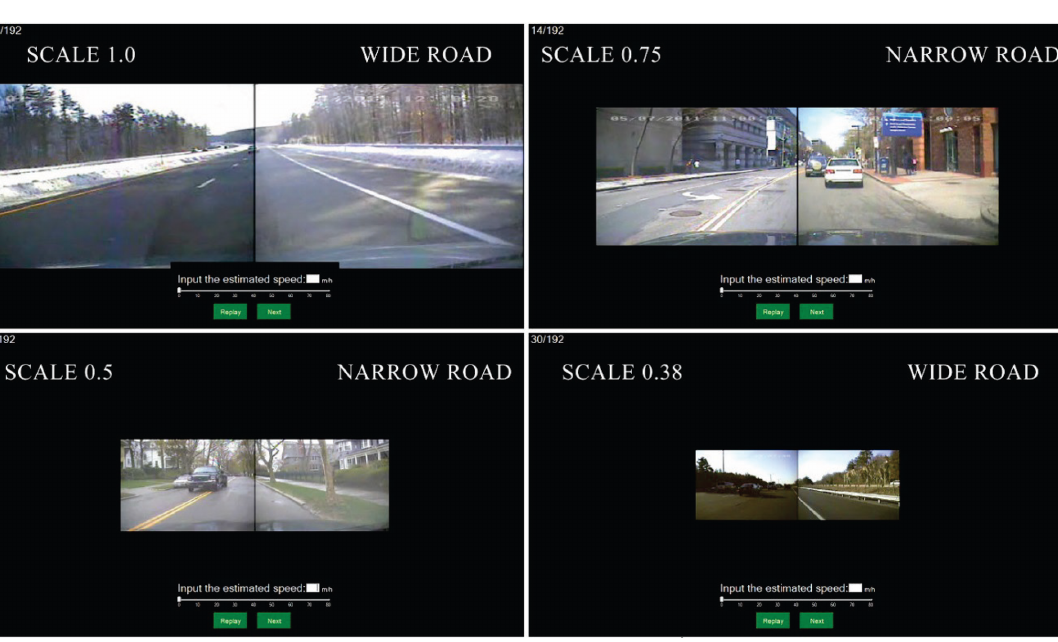
Fig 1. Interface for driving speed estimation systemshowing examples of the narrow and wide road types and 4 image scales (upper left-scale 1.0, upper right-scale 0.75, lower left-scale 0.5, lower right-scale 0.38).